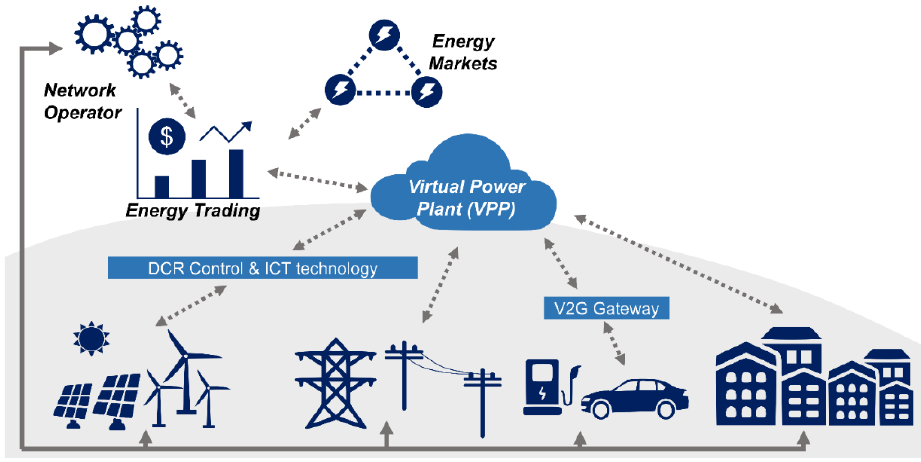
Figure 3. An illustration of V2G units trading energy using VPPs (redrawn from